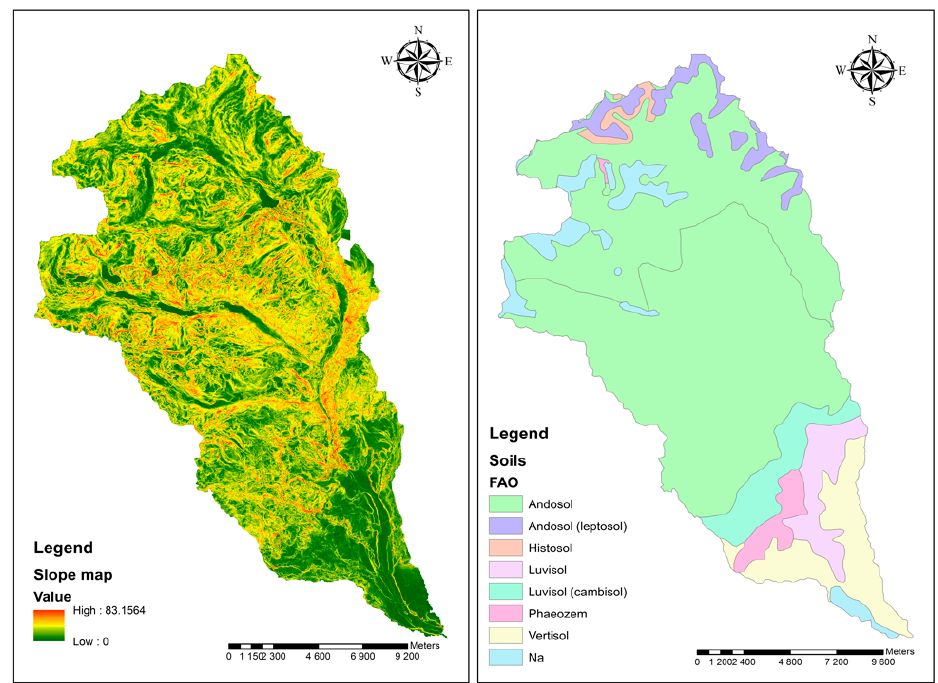
Figure 4. Digital slope model (degrees) and the soil map of the Machángara Basin. [16].